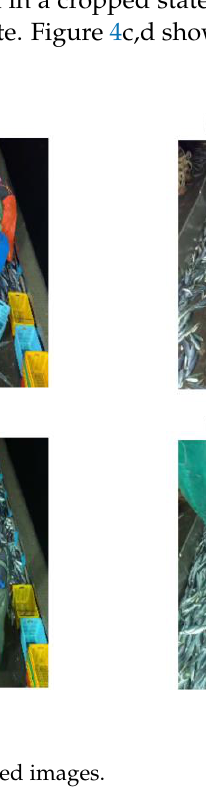
( d ) Figure 4. A comparison of predicted images after setting up the cropped and uncropped images: ( a ) cropped image for a person; ( b ) uncropped image for a person; ( c ) cropped image for a fish; ( d ) uncropped image for a fish. There is a problem of showing errors in estimation, but there is also a problem that the box does not accurately represent the object. In particular, when estimating in (c) and (d), the weights [73] provided by previous studies were used. It is evident that most of the